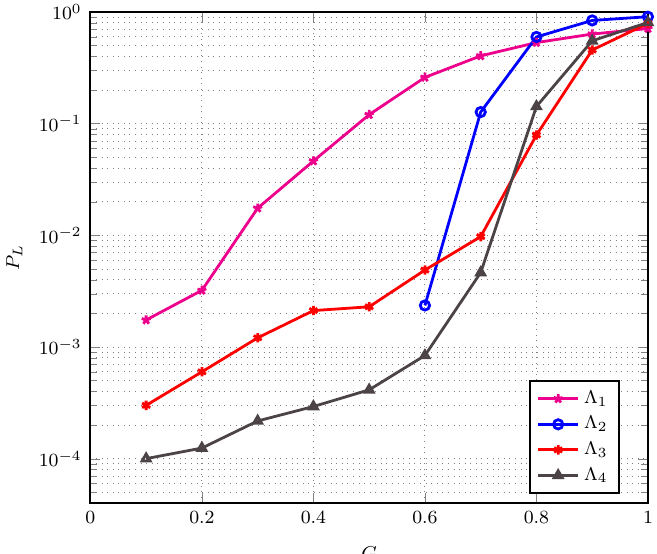
Figure 3. Packet loss rate P L versus instantaneous load G for frame length m = 200 and the distributions in Table